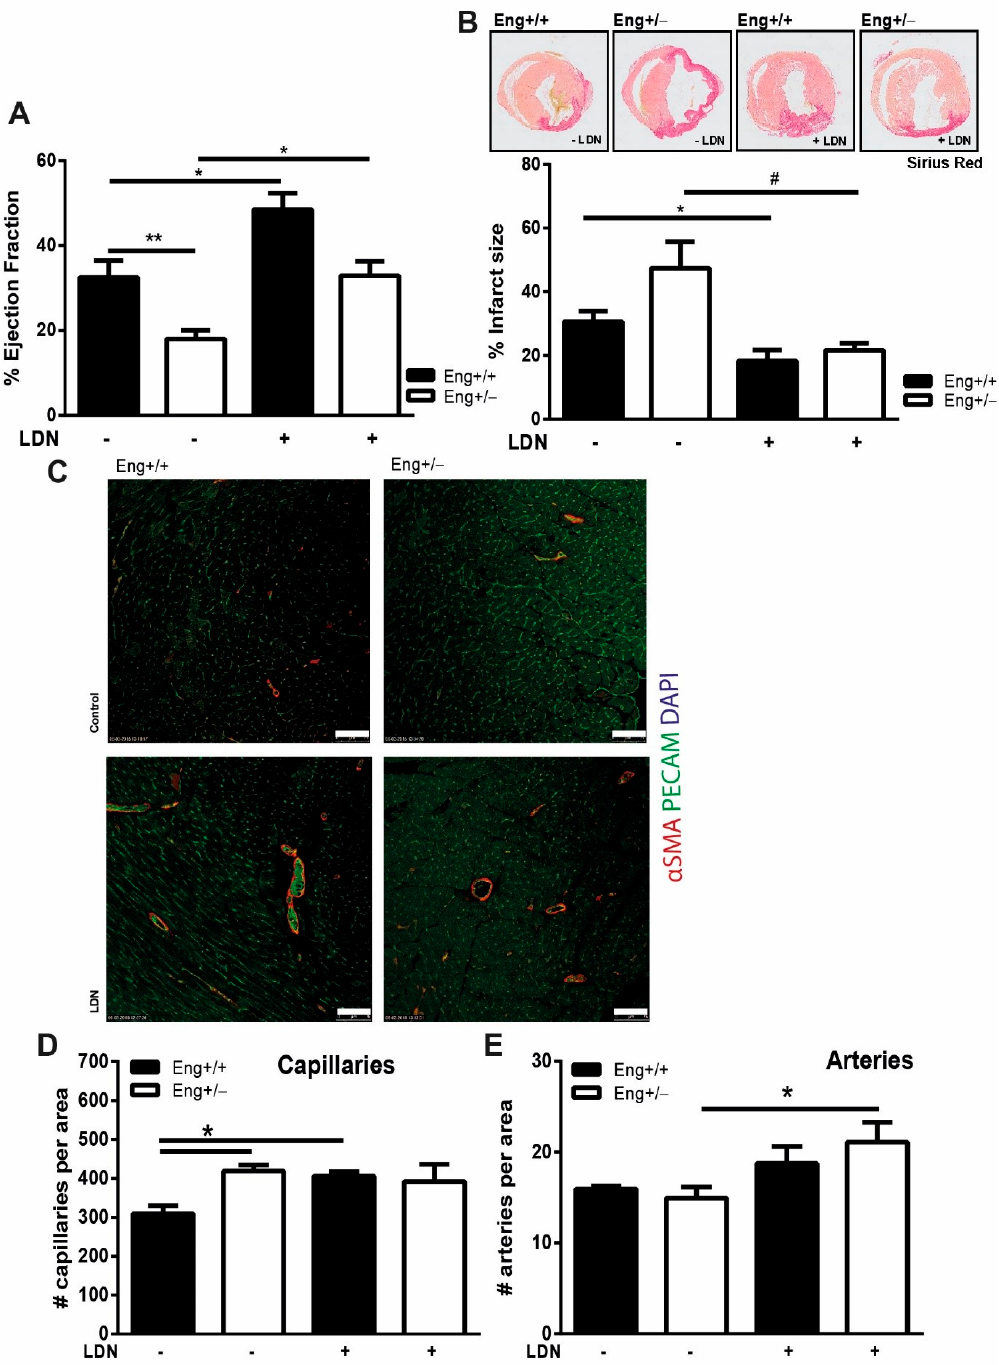
Figure 6. LDN restores cardiac function in Eng+/ − to normal levels 14 days after MI. ( A ) Cardiac ejection fraction of Eng+/+ and Eng+/ − mice 14 days post-MI, treated with LDN or placebo. N = 5–16 mice. ( B ) Infarct size was determined in both Eng+/+ and Eng+/ − mice using Picrosirius Red staining. Top row—representative pictures of murine transversal heart sections. 1.0 × magnification. Bottom row—quantification of infarcted area as percentage of total LV area. N = 5–16 mice per group. ( C , D ) LDN treatment influences cardiac neo-vascularization post-MI. ( C ) Paraffin sections of mouse hearts were stained for PECAM (green) and α SMA (red). N = 5–16 mice per group. Eng+/+ control N = 9, Eng+/ − control N = 5, Eng+/+ LDN N = 6, Eng+/ − LDN N = 16. ( D , E ) Quantification of the number of capillaries ( D ) and arteries ( E ) in ( C ). Scale bar: 50 µ m. * p < 0.05; ** p < 0.01; # p <